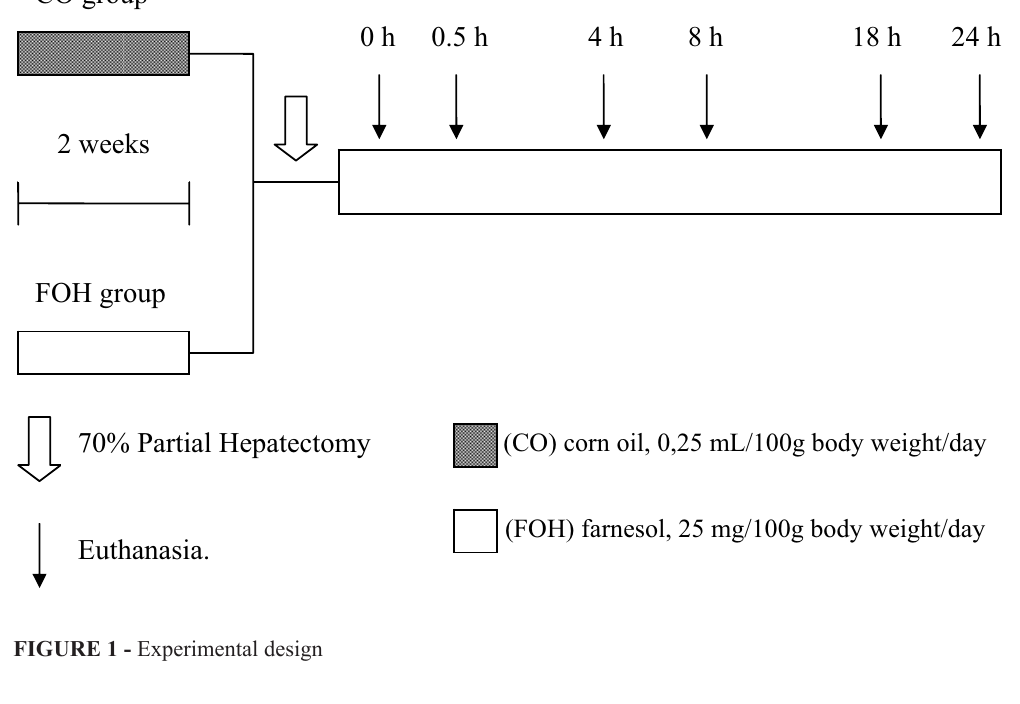
FIGURE 1 - Experimental